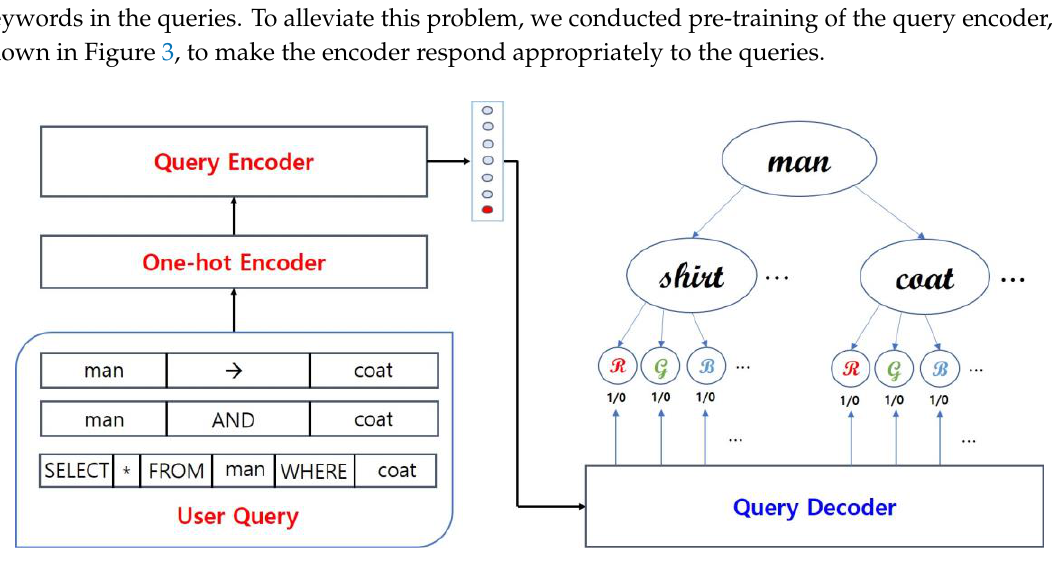
Figure 3. Pre-training of the query encoder.